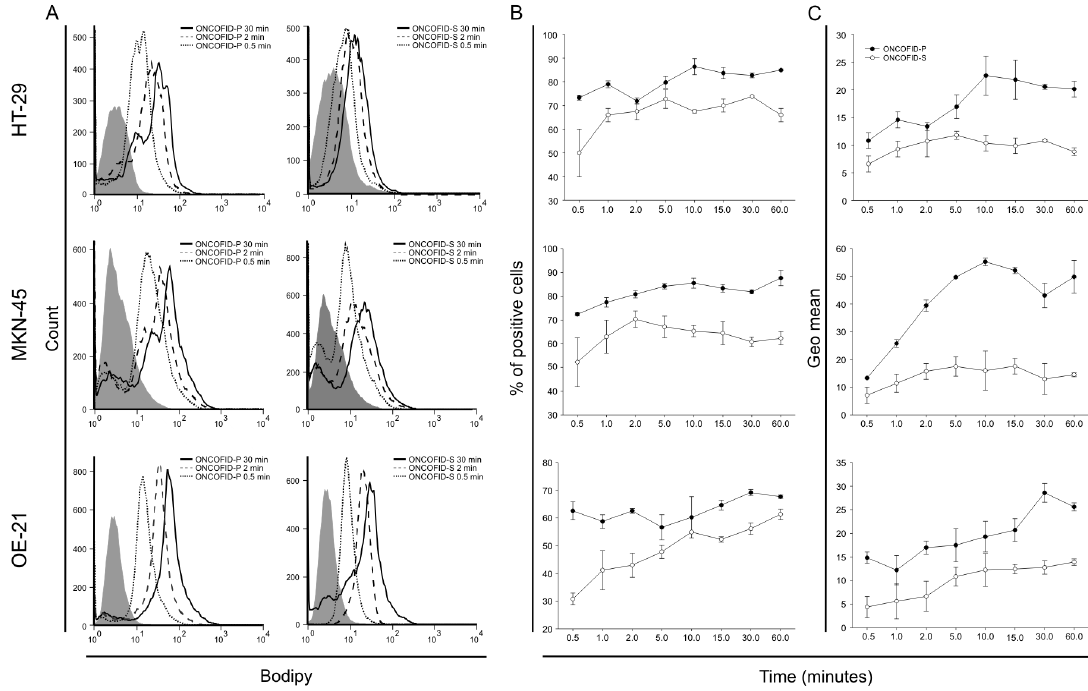
Figure 1. Interaction of bioconjugates with cancer cell lines. A, BODIPY-labeled ONCOFID-P (50 m g/mL in paclitaxel equivalents) or ONCOFID- S (50 m g/mL in SN-38 equivalents) were added to tumor cells and flow cytometry analysis was performed at different time points thereafter (0.5, 1, 2, 5, 10, 15, 30 or 60 minutes). Panels illustrate cytometry profiles at 3 representative time points. B, whole kinetics of interaction at all time points tested. C, kinetics of the fluorescence intensity (geo mean) detected on tumor cells at the same time points analysed as in B. Panels B and C report mean 6 SD of 3 independent experiments.